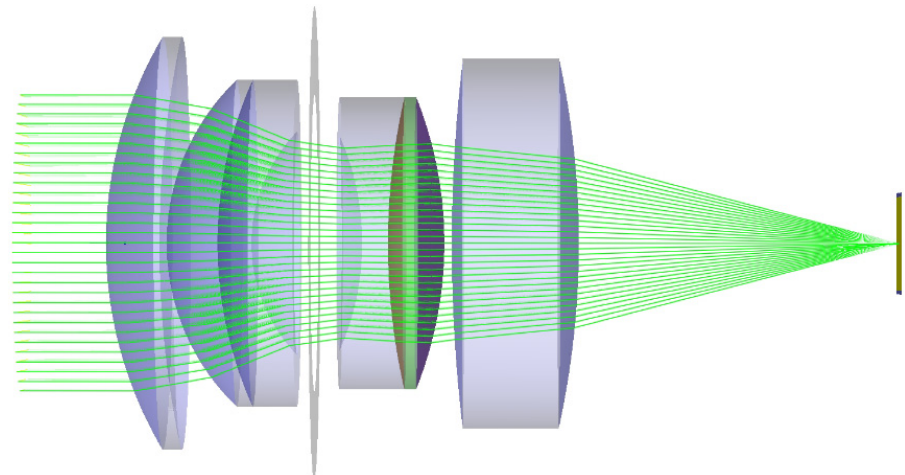
Figure 8. Typical optical layout of a generic Double-Gauss type camera lens.